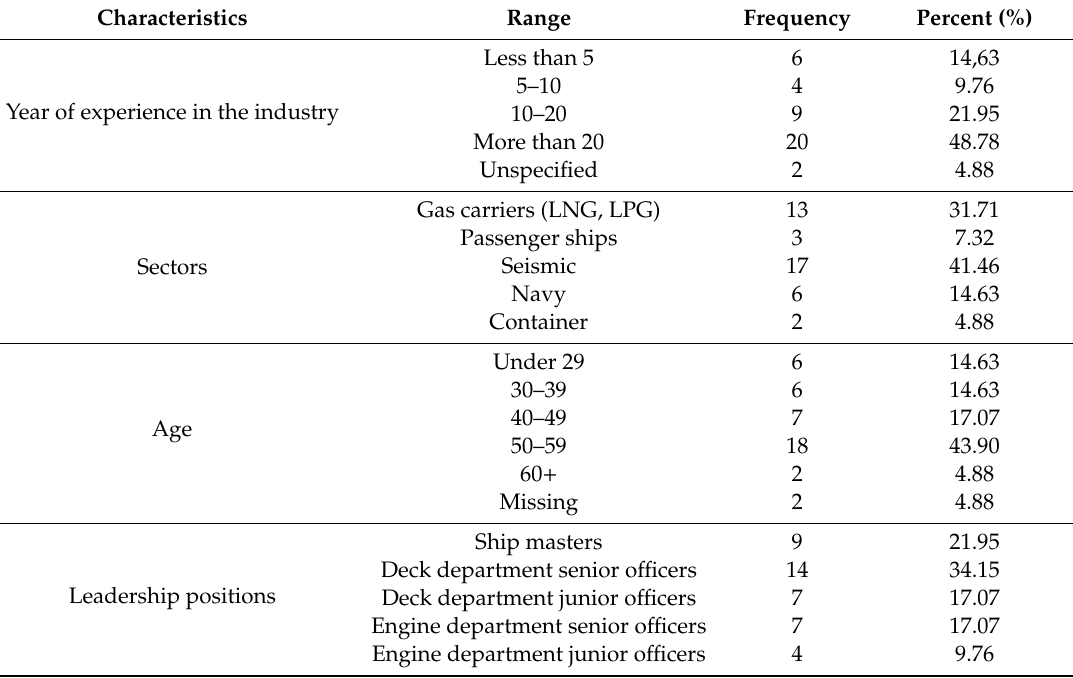
Table 3. Demographic characteristics of